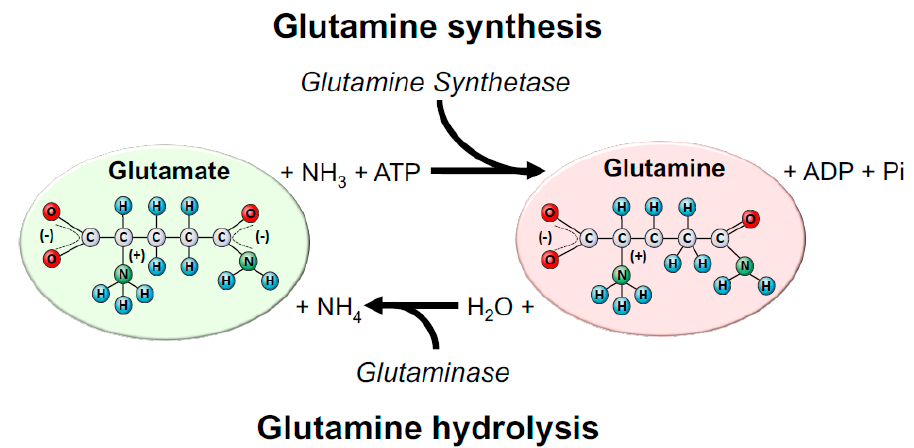
Figure 1. Glutamine synthesis and hydrolysis. Glutamine is mainly synthesized by the enzyme glutamine synthetase (GS) and hydrolysed by the enzyme, glutaminase (GLS). GS catalyses glutamine biosynthesis using glutamate and ammonia (NH 3 ) as a source. In this reaction, one ATP is consumed. Glutamate can be donated by many amino acids obtained exogenously (i.e., diet) and/or from endogenous amino acids’ catabolism. On the other hand, GLS is responsible for glutamine hydrolysis to glutamate and ammonium ion (NH 4 ). Almost all cells in the body express GS and GLS, and their predominant expression and activity will dictate if the tissue is more likely to produce or consume glutamine in health and disease.